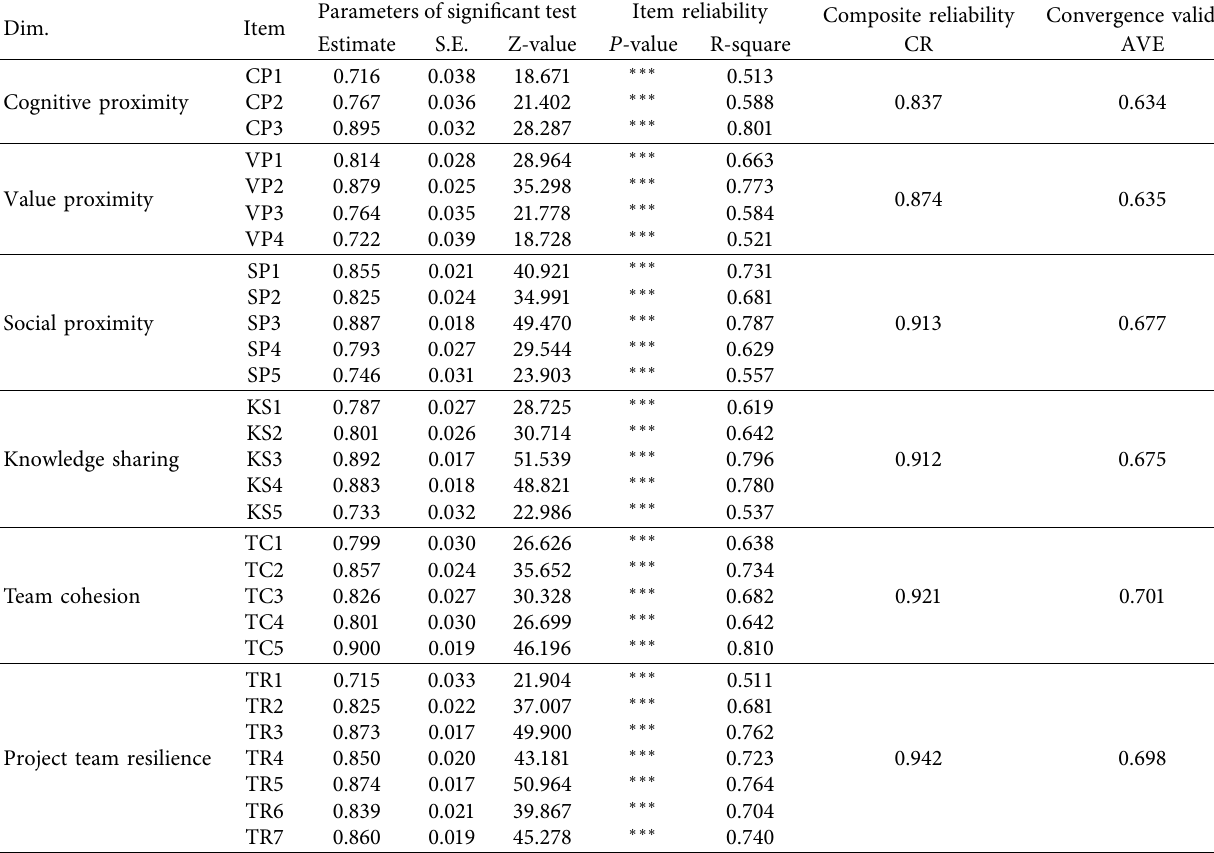
Table 3: Reliability and convergence validity.